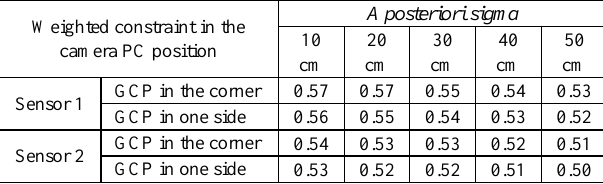
Table 3. A posteriori sigma in the BBA ( a priori sigma = 0.50 ).